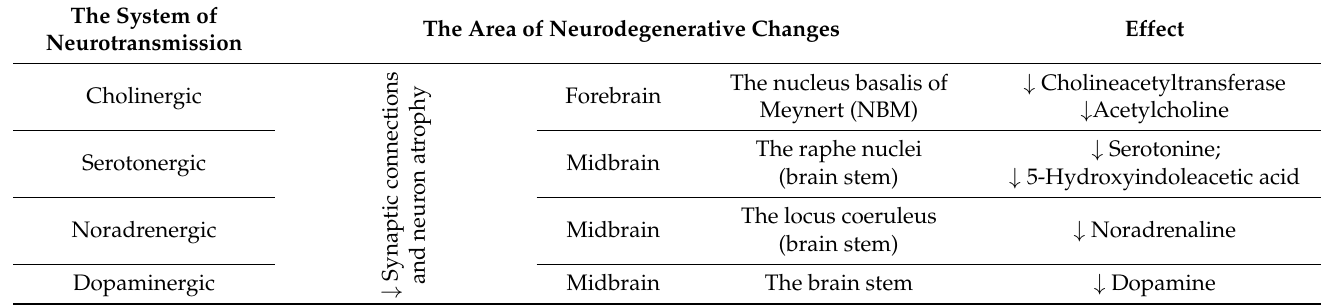
Table 1. Abnormalities in neurotransmission systems throughout the course of